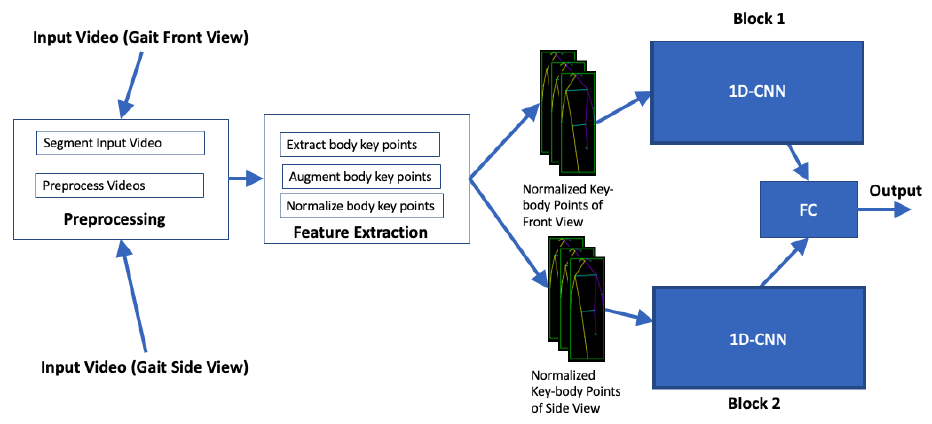
Figure 6. Overview of the proposed system.